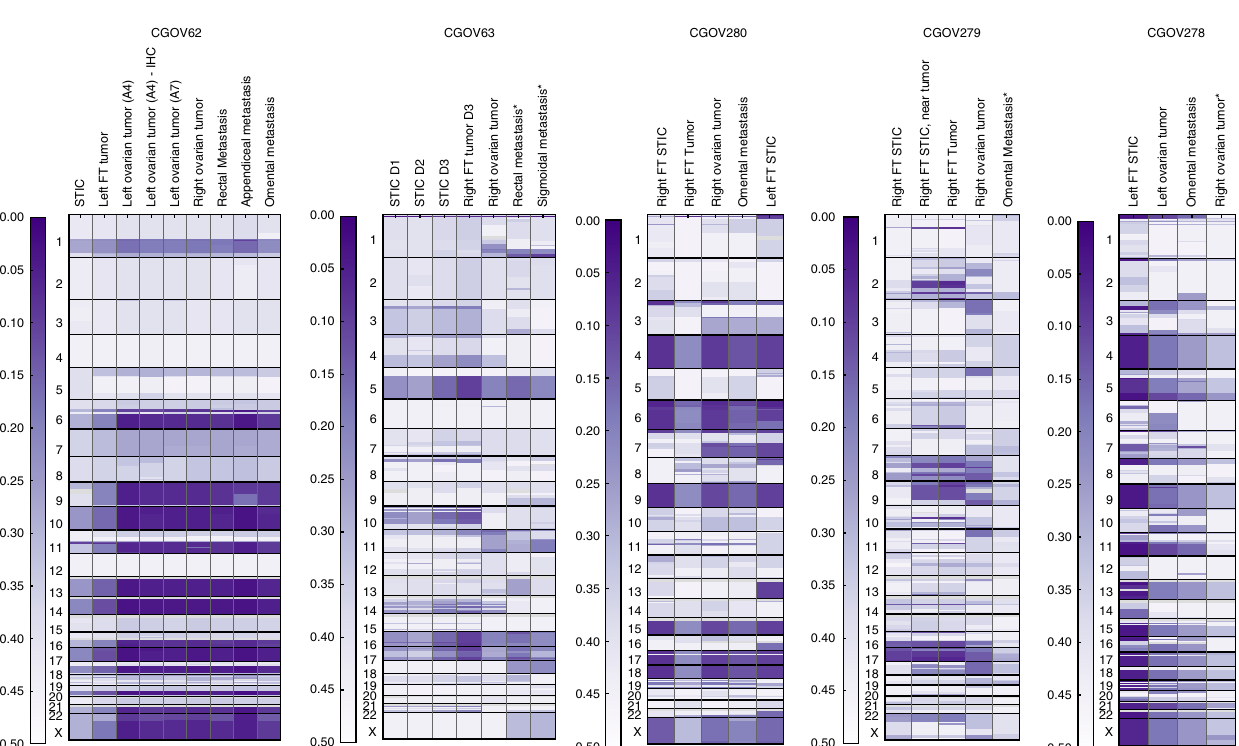
Fig. 3 Genome-wide allelic imbalance pro fi le. Minor allele frequency of heterozygous SNPs identi fi ed from normal tissue in each patient are derived in each tumor sample, enabling assessment of allelic imbalance in ~17,000 loci across the exome. Circular binary segmentation (CBS) is applied to minor allele frequencies of SNPs with minimum coverage of 10× in each tumor sample, and the resulting segment means are shown as a heatmap. Asterisks indicate samples where corresponding mutation analyses were not performed due to low tumor purity (omental metastasis of CGOV279, right ovarian tumor of CGOV278) or miliary pattern of tumor samples (peritoneal metastases of CGOV63). Given the relatively lower number of distinct DNA molecules available from the p53 signature samples from CGOV62 and CGOV63, these samples were subjected to a more sensitive LOH analysis (Methods, Genome-wide imbalance analysis) and are not shown